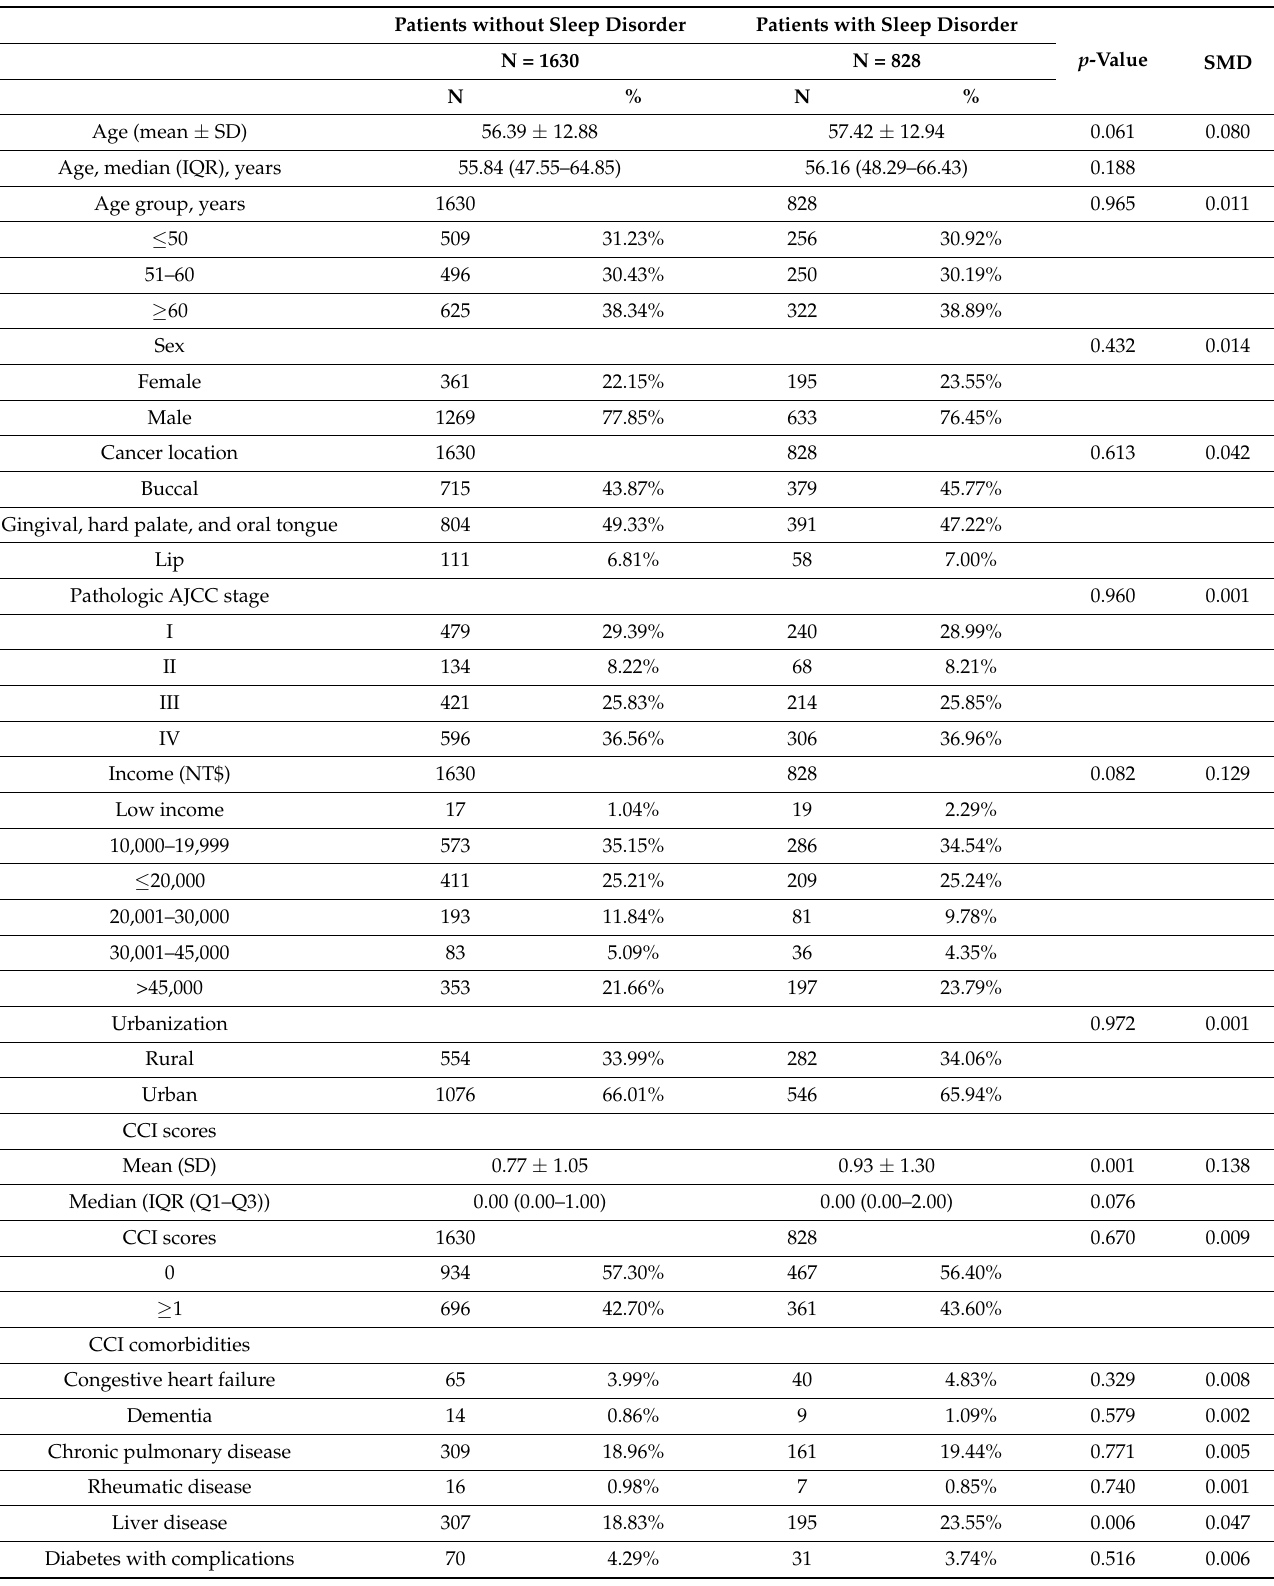
Table 1. Characteristics of propensity score-matched patients with and without sleep disorders before oral cavity squamous cell carcinoma